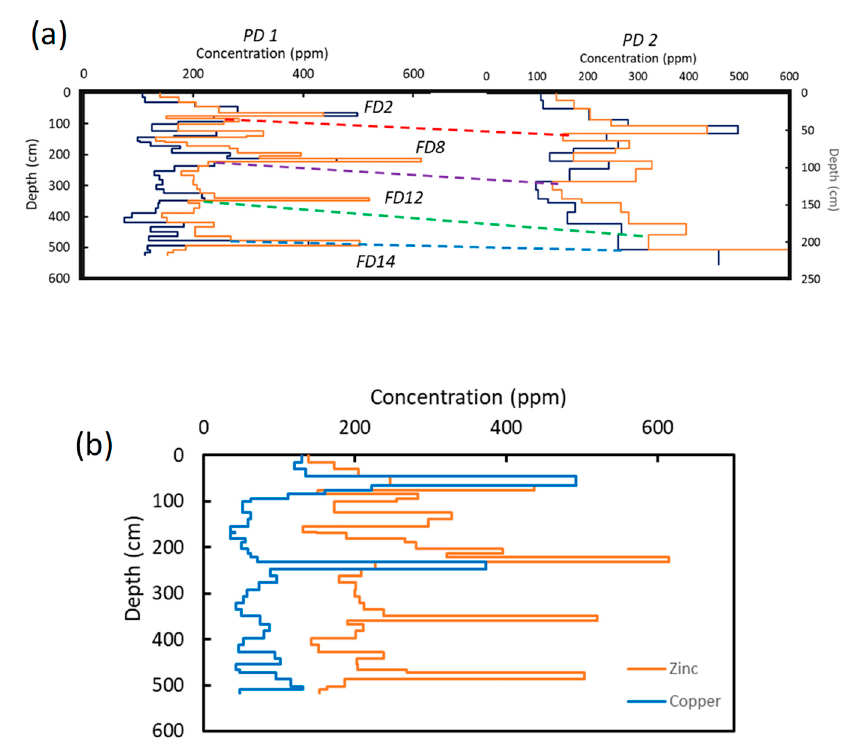
Figure 13. ( a ) Vertical patterns in Zn (orange) and As (blue) concentrations at PD1 and PD2. Dashed lines of various colors show possible correlations between flood deposits based on Zn and As contents; ( b ) comparison of Zn and Cu concentrations at PD1, illustrating differences in concentration between events.